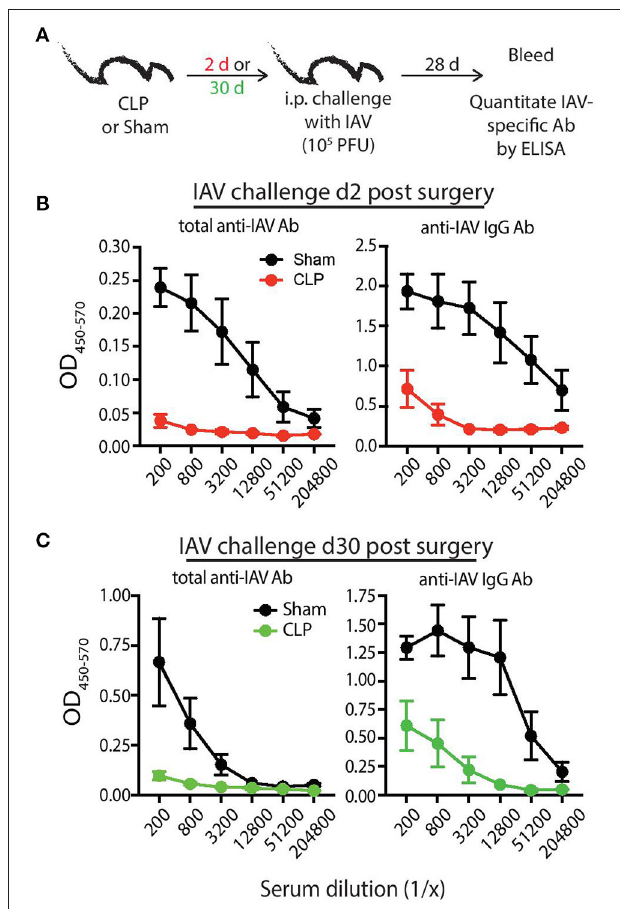
FIGURE 6 | Septic mice have reduced primary Ab response following influenza A virus (IAV) challenge. (A) Experimental design—B6 mice were challenged with live IAV (A/PR/8; 10 5 PFU in 100 µ l PBS i.p.) 2 or 30 days after sham or CLP surgery. Serum was collected 28 days after immunization. (B) Absorbance of total anti-IAV Ab (left) and IgG specific for IAV (right) from the indicated dilutions of serum from mice challenged 2 days after surgery. (C) Absorbance of total anti-IAV Ab (left) and IgG specific for IAV (right) from the indicated dilutions of serum from mice challenged 30 days after surgery. n = 4–6 mice/group. Data are representative of at least 2 independent experimental